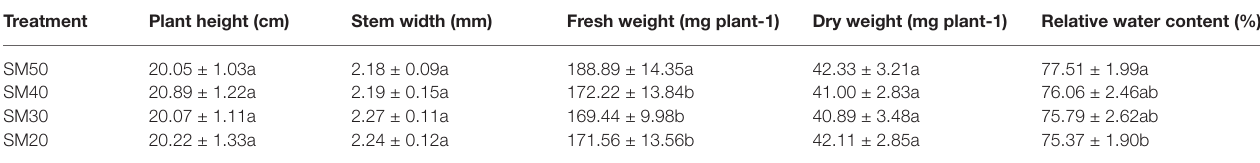
Data represent the mean of five data ± standard error. Different letter above the table indicates difference at p < 0.05 by LSD